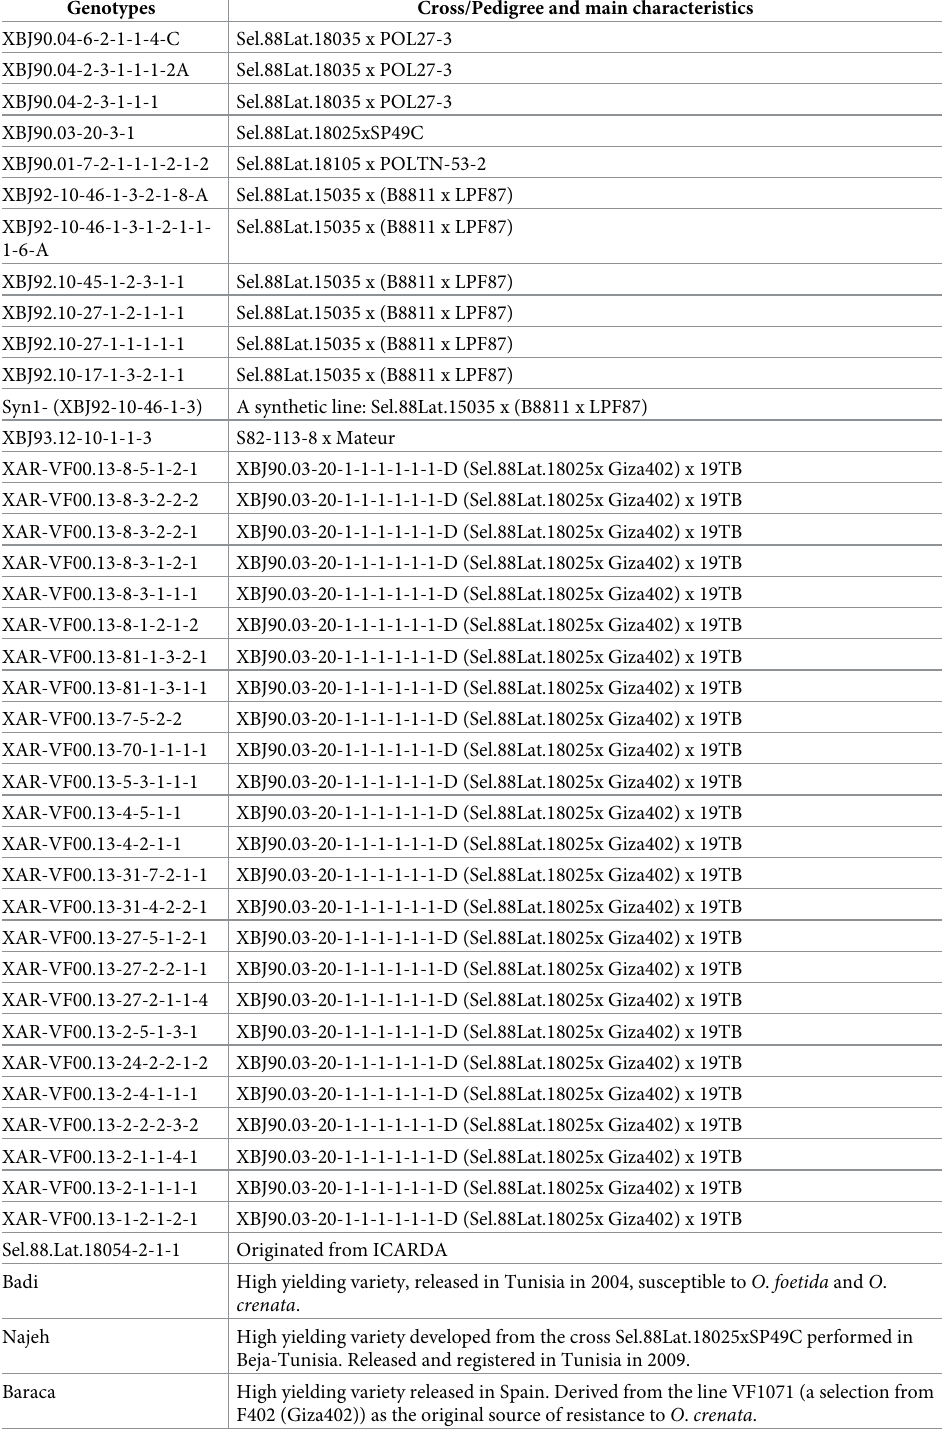
Table 1. Origin and main characteristics of different studied